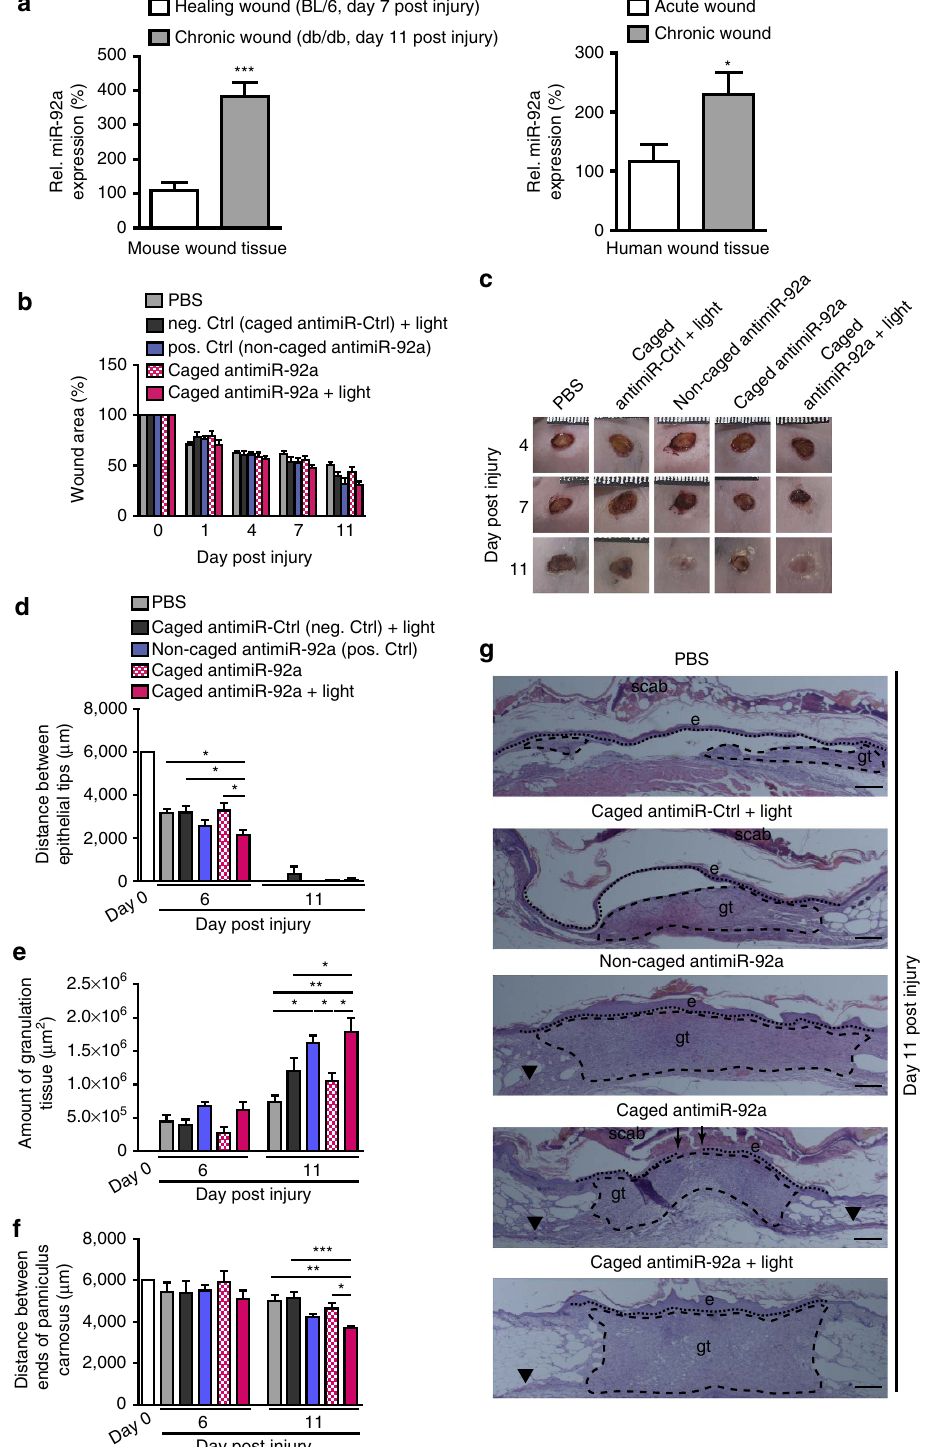
Figure 2 | Caged antimiR-92a treatment improves wound healing in db/db mice. ( a ) miR-92a expression level quantified by real-time PCR in murine and human wound tissue as indicated. ( b ) Macroscopic quantification of the wound size over time postwounding. Different groups as indicated. ( c ) Representative photographs of the quantified wound area at different time points post injury. Morphometric quantification of ( d ) the length of reepithelialization, as a measure for the wound size; ( e ) the amount of granulation tissue, as a measure for wound quality; and ( f ) the distance between the ends of panniculus carnosus, as a measure for wound contraction. ( g ) Representative haematoxylin and eosin stainings of wound tissue 11 days post injury. Different groups as indicated. n ¼ 4–14 wounds per group on 3–7 different mice. Dotted line marks epithelial dermal border and dashed line highlights the granulation tissue. Arrows point to epithelial tips and arrow heads to the end of panniculus carnosus. e, hyperproliferative epithelium; gt, granulation tissue. Scale bars, 300 m m. Data are expressed as means ± s.e.m. Significance of difference was analysed using analysis of variance one-way test analysis with Newman–Keuls Multiple Comparison Test. *** P o 0.001, ** P o 0.01, * P o